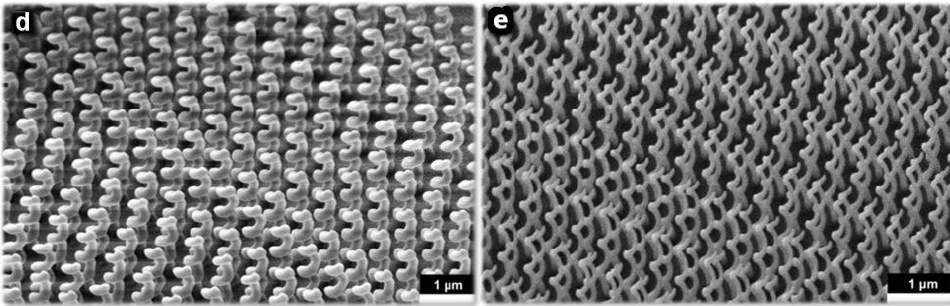
Figure 2. Plasmonic spiral structure and its fabricating process based on Focused Ion − beam (FIB). ( a ) SEM representation of the 3D FIBID nanohelix growth as a function of ion energy and step size. ( b ) SEM representation of the 3D FEBID nanohelix growth as a function of ion energy and step size. ( c ) In FEBID process, the single loop nanohelix VP strongly depends on the primary electron acceleration voltage. ( d ) Array of 20 × 20 3D chiral plasmonic nanohelices fabricated by FIBID. ( e ) Array of 40 × 40 3D chiral plasmonic nanohelices realized by FEBID. Reproduced with permission from reference [34]. Copyright 2015 American Chemical Society.